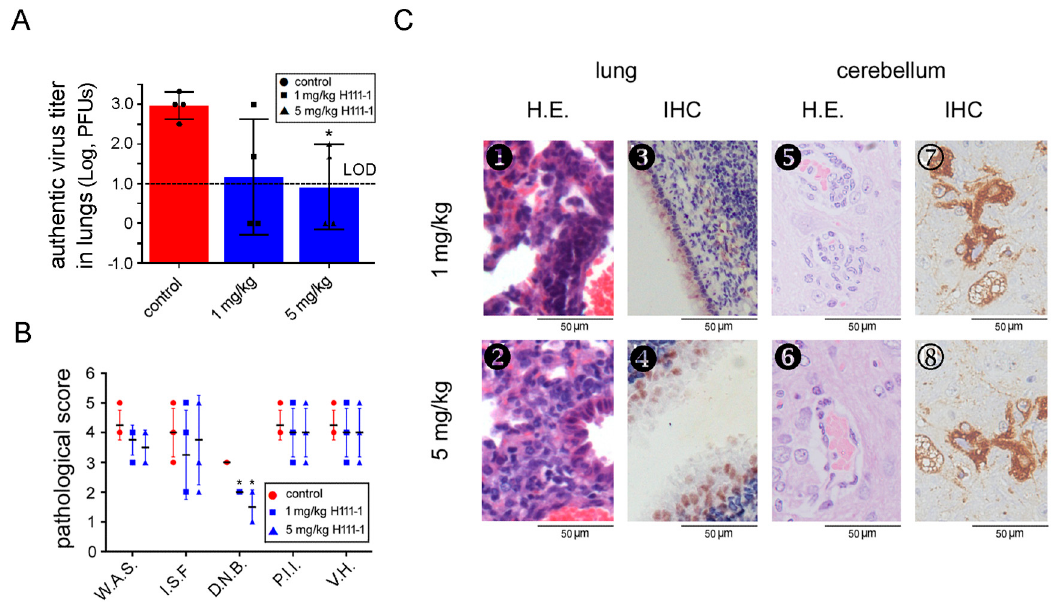
Figure 3. MERS-CoV S-RBD-specific humanized neutralizing antibody H111-1 protected R26-hDPP4 mice from challenge with authentic MERS-CoV. Four-week-old mice were administered either PBS (control), 1 mg/kg mAb H111-1 or 5 mg/kg mAb H111-1 via the I.P. route, and 6 h later they were challenged I.N. with hCoV-EMC (1.5 × 10 5 PFUs). On day 5 p.i., mice were sacrificed for virus titering